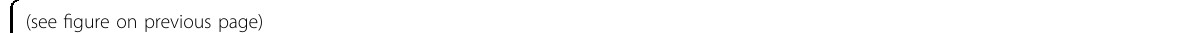
Fig. 4 YAMTAD system for cognate TCR screening and library-on-library screening. a Ratios (mean ± sd) of the 868 TCR mutants to the GAHDY*LN TCR in diploid yeasts induced in the YAMTAD screening. The NC peptides include TAX and 3*. Each experiment was performed with 4 technical repeats and was independently duplicated 2 times. The mean of 8 duplicates is shown. b The median MFI (mean± sd) of the indicated 868 TCR mutants stained with PE fl uorescently labeled SL9-HLA-A*02:01 tetramer. c A schematic diagram of the barcoding strategy used in library-on- library screening. A unique barcode was added to each TCR or pMHC strain. Expression of Cre recombinase induces recombination between the loxp 66 and loxp 71 sites, resulting in a juxtaposition of the MATa and MATalpha barcodes on the same chromosome. The two barcodes could be ampli fi ed by speci fi c primers and subsequently sequenced simultaneously. d Ratios (mean ± sd) of diploids induced by the indicated peptide-TCR pairs to diploids induced by the negative control, the peptide-TAX 8* -TCR, in the YAMTAD library-on-library screening. The fi ve peptides used for screening were mixed equally. Each experiment was performed with 4 technical repeats and was independently duplicated 3 times. The mean of 12 duplicates is shown. e Ratios (mean± sd) of diploids induced by the indicated peptide-TCR pairs to diploids induced by the negative control, the peptide-3* -TCR, in the YAMTAD library-on-library screening. The SL9, 3 L, and TAX 8* peptides were mixed with the negative yeasts-3* and TAX at a 1:10 2 ratio. Each experiment was performed with at least 3 technical repeats and was independently duplicated twice. The mean of 7 replicates is shown. f Ratios (mean± sd) of diploids induced by the indicated peptide-TCR pairs to diploids induced by the negative control, the peptide-3* -TCR, in the YAMTAD library-on-library screening. The SL9, 3 L, and TAX 8* peptides were mixed with the negative yeast- 3* and TAX at a 1:10 4 ratio. Each experiment was performed with at least 3 technical repeats and was independently duplicated twice. The mean of 7 replicates is shown. Unpaired two-tailed Student ’ s t-test was used for statistical analysis in a , d , e , f . ** indicates a two-tailed P value < 0.01. * indicates a two-tailed P value <